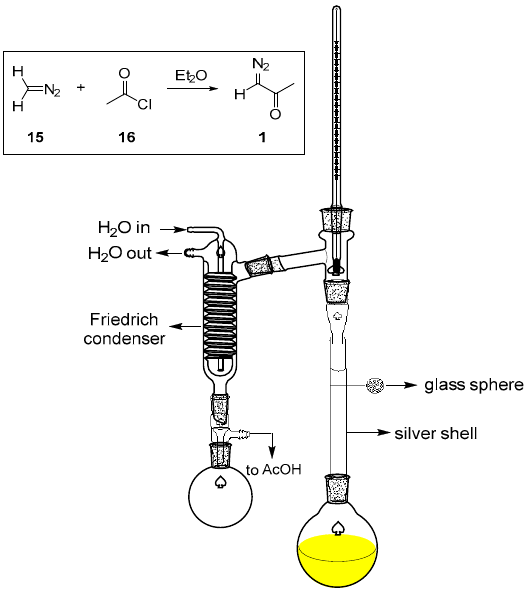
Figure 1. Apparatus used for the preparation and isolation of diazoacetone ( 1 ).